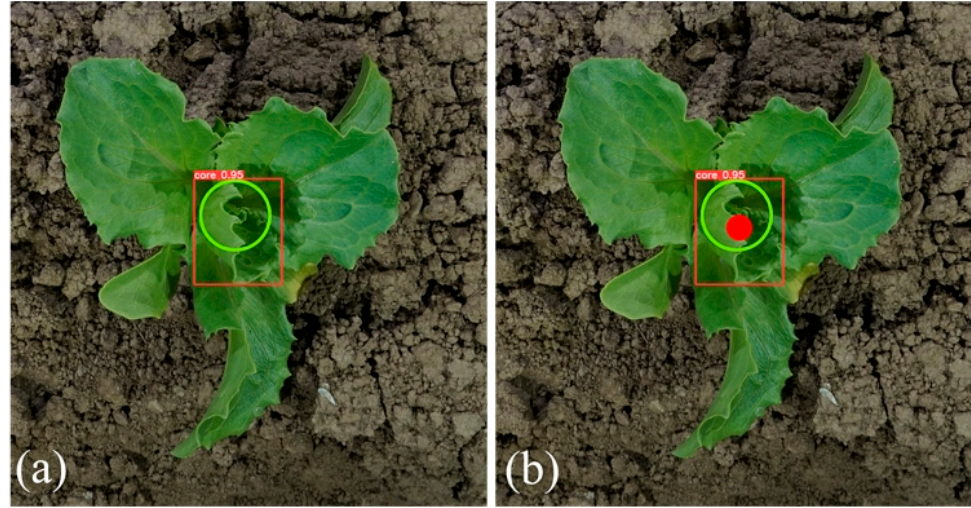
Figure 12. ( a ) The SE-YOLOv5x identification results of the tender leaves; ( b ) localization results.